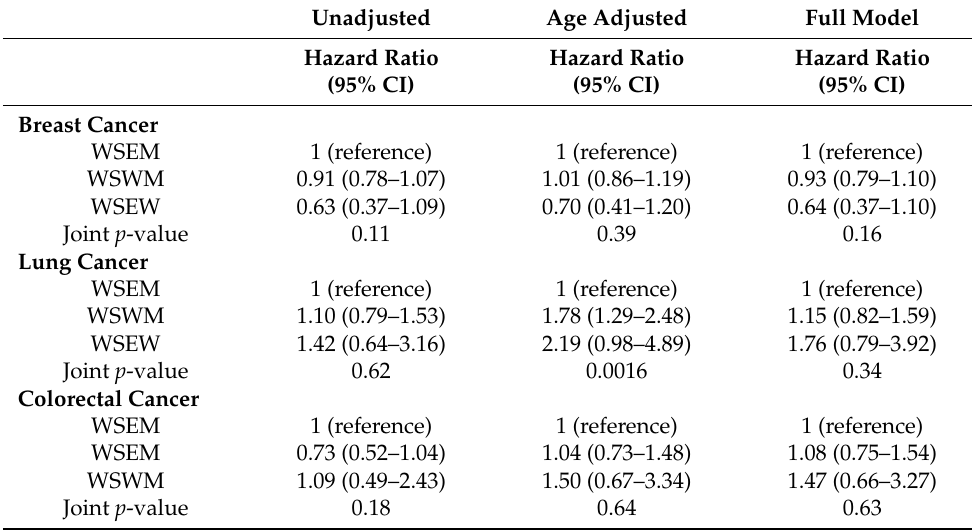
Table A3. Models of breast, lung, and colorectal cancer in women.